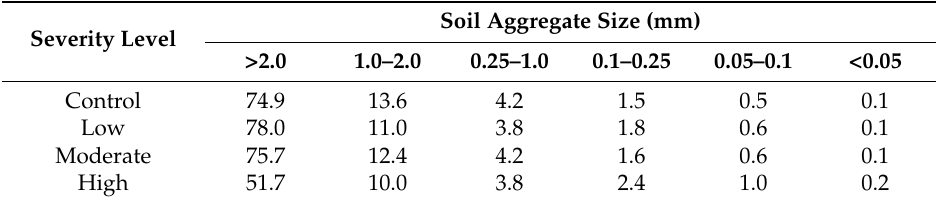
Table 3. Average soil aggregate size distribution (%) in relation to soil burn severity levels (control, low, moderate,